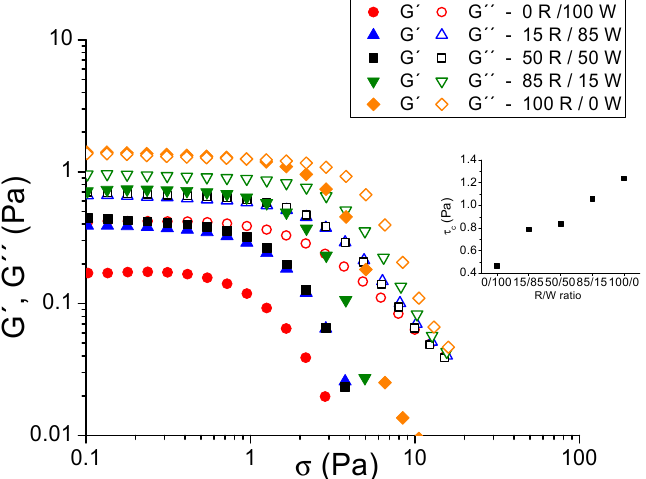
Figure 2. Stress sweeps for the continuous phases passed through a microfluidizer at 350 bar as a function of the rhamsan–welan ratio at 0.1 Hz. Fluids 2019 , 4 , x